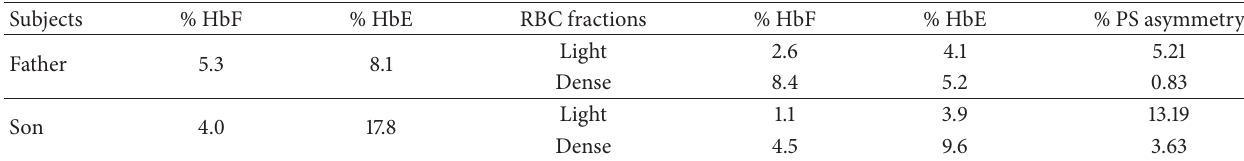
Table 5: Relative percentage of HbF and HbE in various samples and their relative percentage in dense and light density fractions and their respective PS asymmetries.